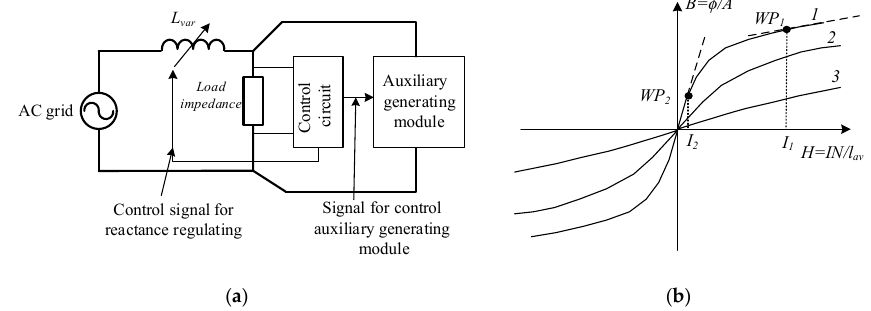
Figure 1. ( a ) The schematic of load power regulation through controllable reactance, ( b ) Non-linear magnetic curves of controllable reactance for different DC currents in the control winding [ B is magnetic flux density, φ is magnetic flux, l is the average path of magnetic lines in the core, A is cross-section of core, H is field strength, I is current in the coil, WP 1 is working point at I 1 , and WP 2 is working point at I 2 ].